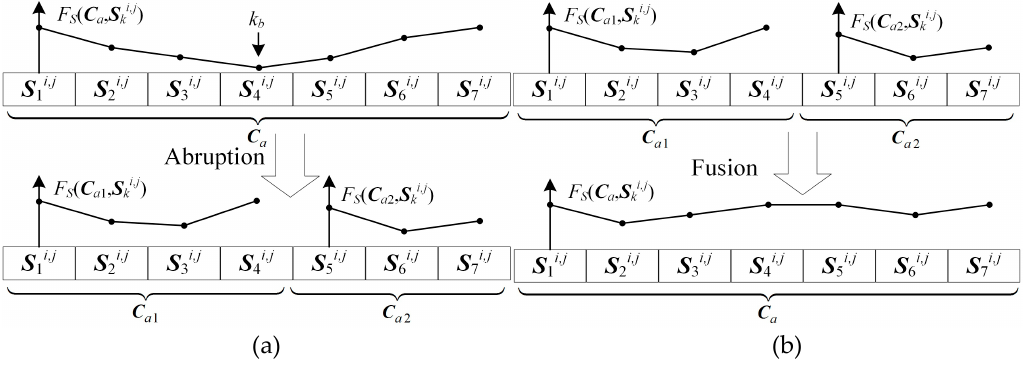
Figure 3. ( a ) An example on the tracklet abruption. ( b ) An example on the tracklet fusion. The α , β , δ solutions are free from the selection, abruption, and fusion.